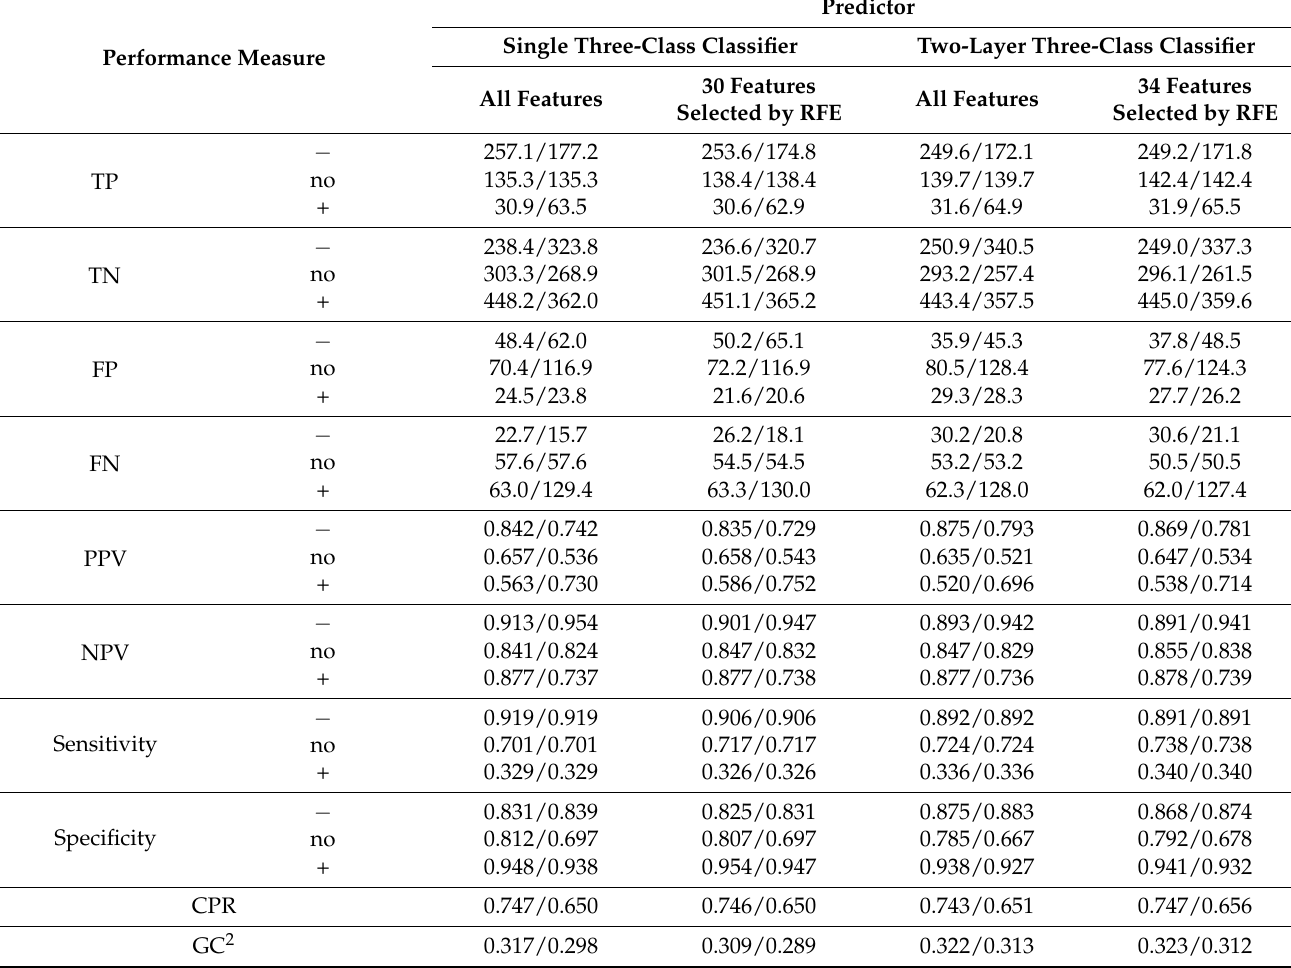
Table 4. Comparison of different three-class LightGBM classifier designs on 10-fold